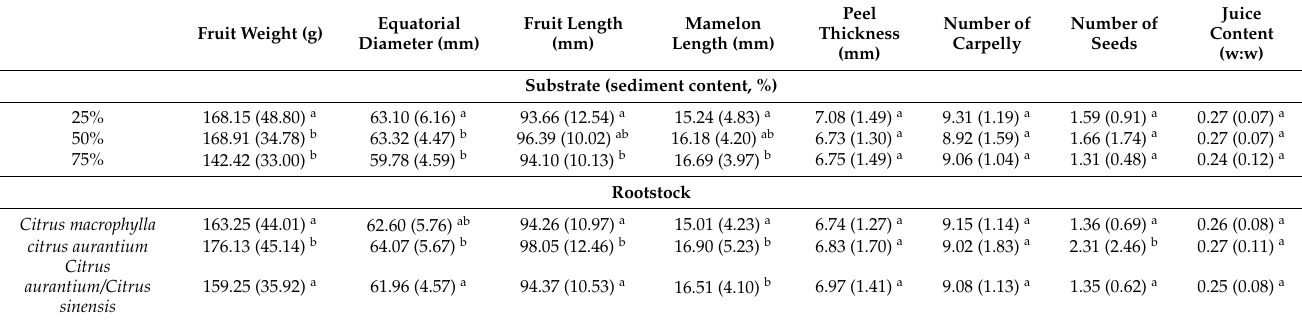
Table 3. Morphological characteristics of the ‘Verna’ lemons obtained depending on the type of substrate and the rootstock used. The results correspond to the mean values with their standard deviation in